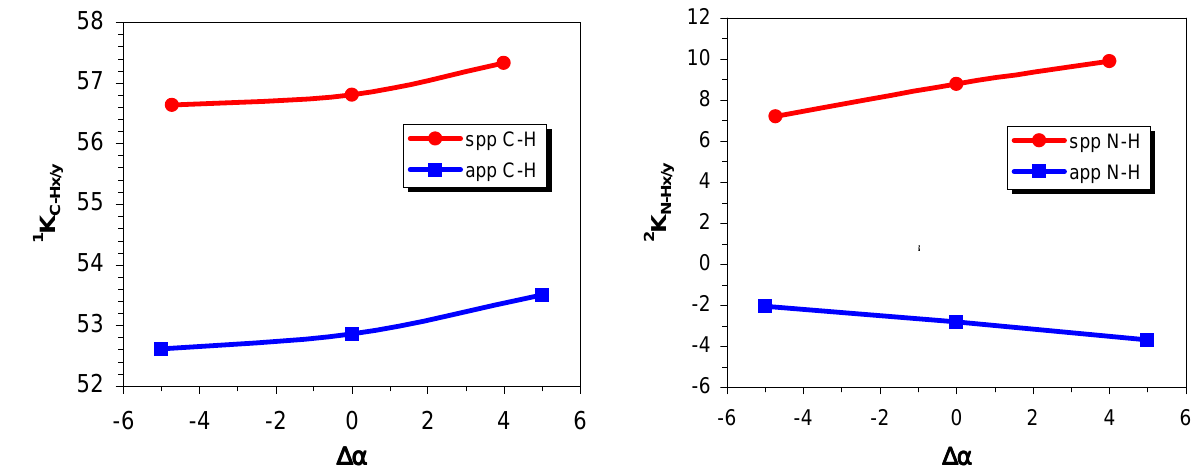
) and 2 K (N,H ) couplings (in 10 19 T 2 J -1 ) on X/Y X/Y — and — angles, (cid:3) , from their equilibrium CNH X CNH Y